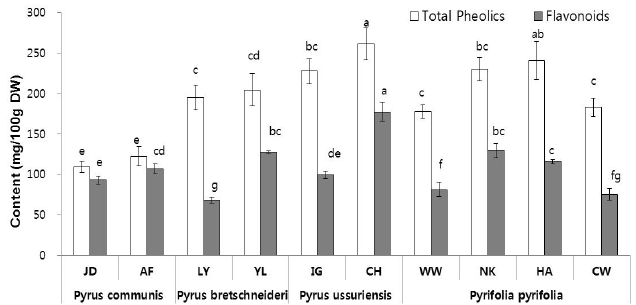
Fig. 1: Total phenolic and flavonoid contents of 10 different pear cultivars. Value are means ± SD ( n = 3). Different letters (a to g) of each indi- cate significant difference at P < 0.05 according to DMR test. The cultivars used are Jules d’Airolles (JD), Abate Fetal (AF), Laiyang- chili (LY), Yali (YL), Ingyebae (IG), Cheongbae (CH), Wonwhang (WW), Niitaka (NK), Hanareum (HA), and Chuwhang